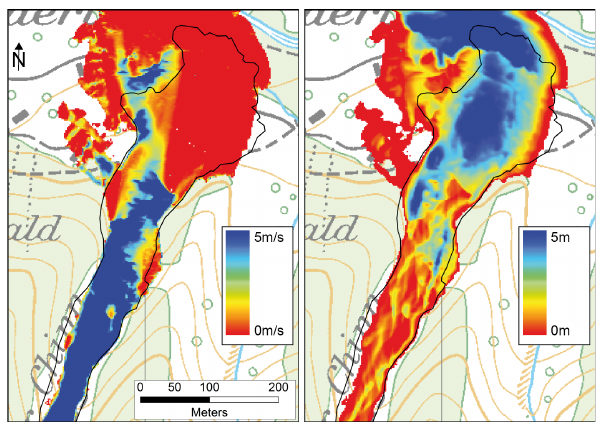
Fig. 14. Simulation ] 1. Screen shot of a velocity field around the dam (left) and the corresponding flow depth (right). The model predicts that the avalanche body will decelerate during the impact with the dam and a large deposit will form. The avalanche impacts the dam at a sharp inclination